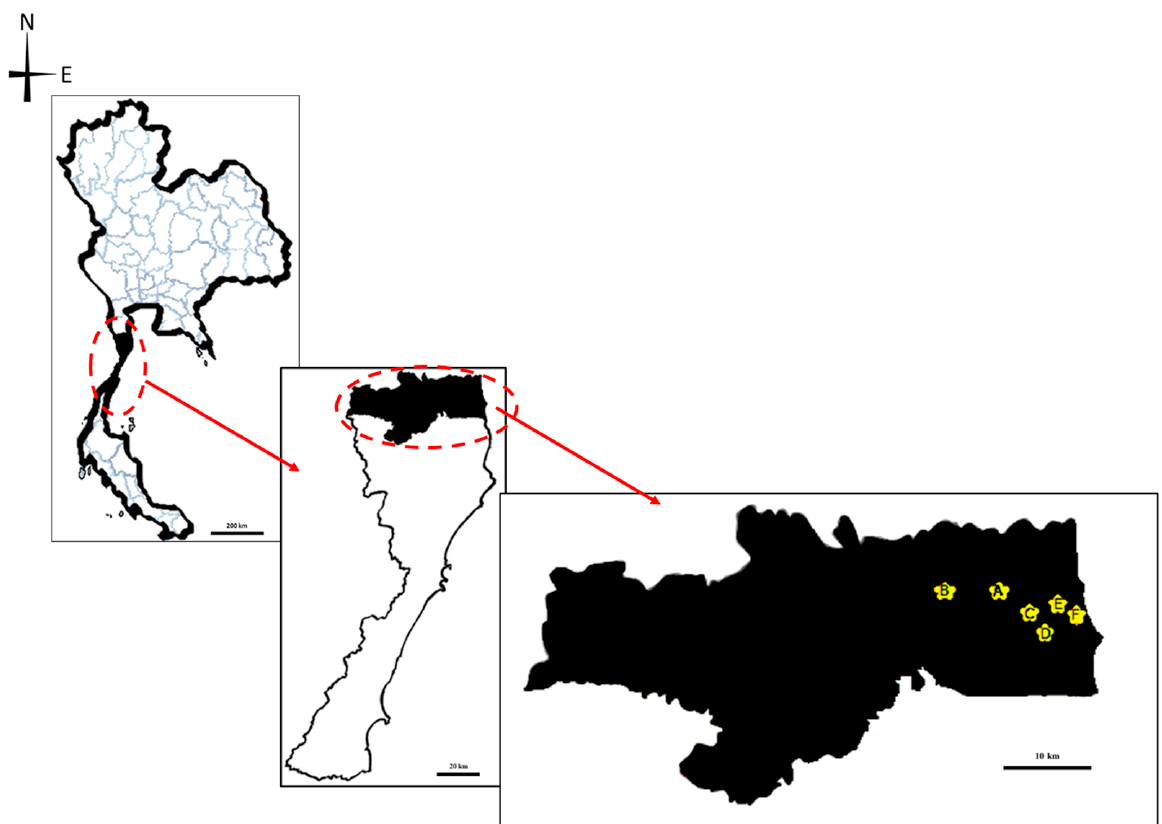
Figure 1. Map of the studied area in Hua Hin district, Prachuab Khiri Khan province, Thailand.